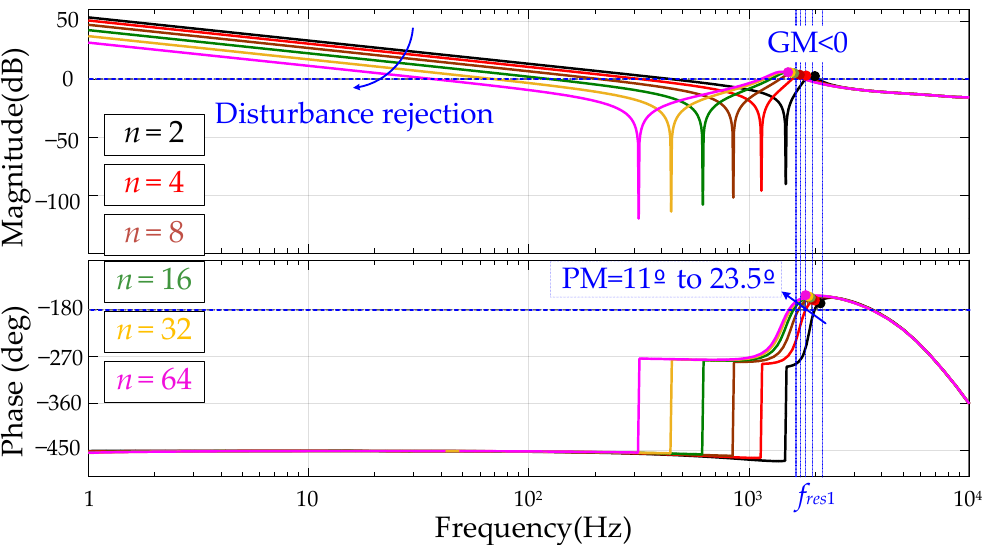
Figure 5. Frequency response of the common current under n = 2, 4, 8, 16, 32 and 64 with the conventional control scheme.